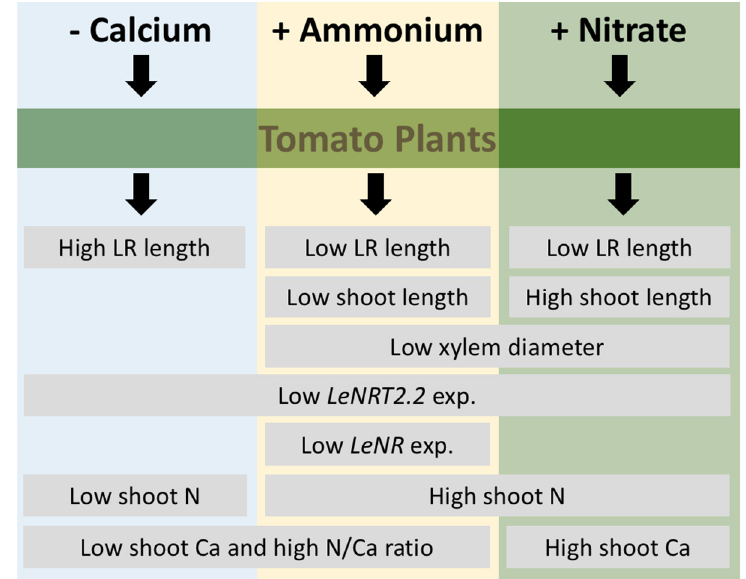
Figure 7. Proposed roles of Ca restrictions (−), as well as ammonium (+) and nitrate (+) excesses on tomato plant physiology and